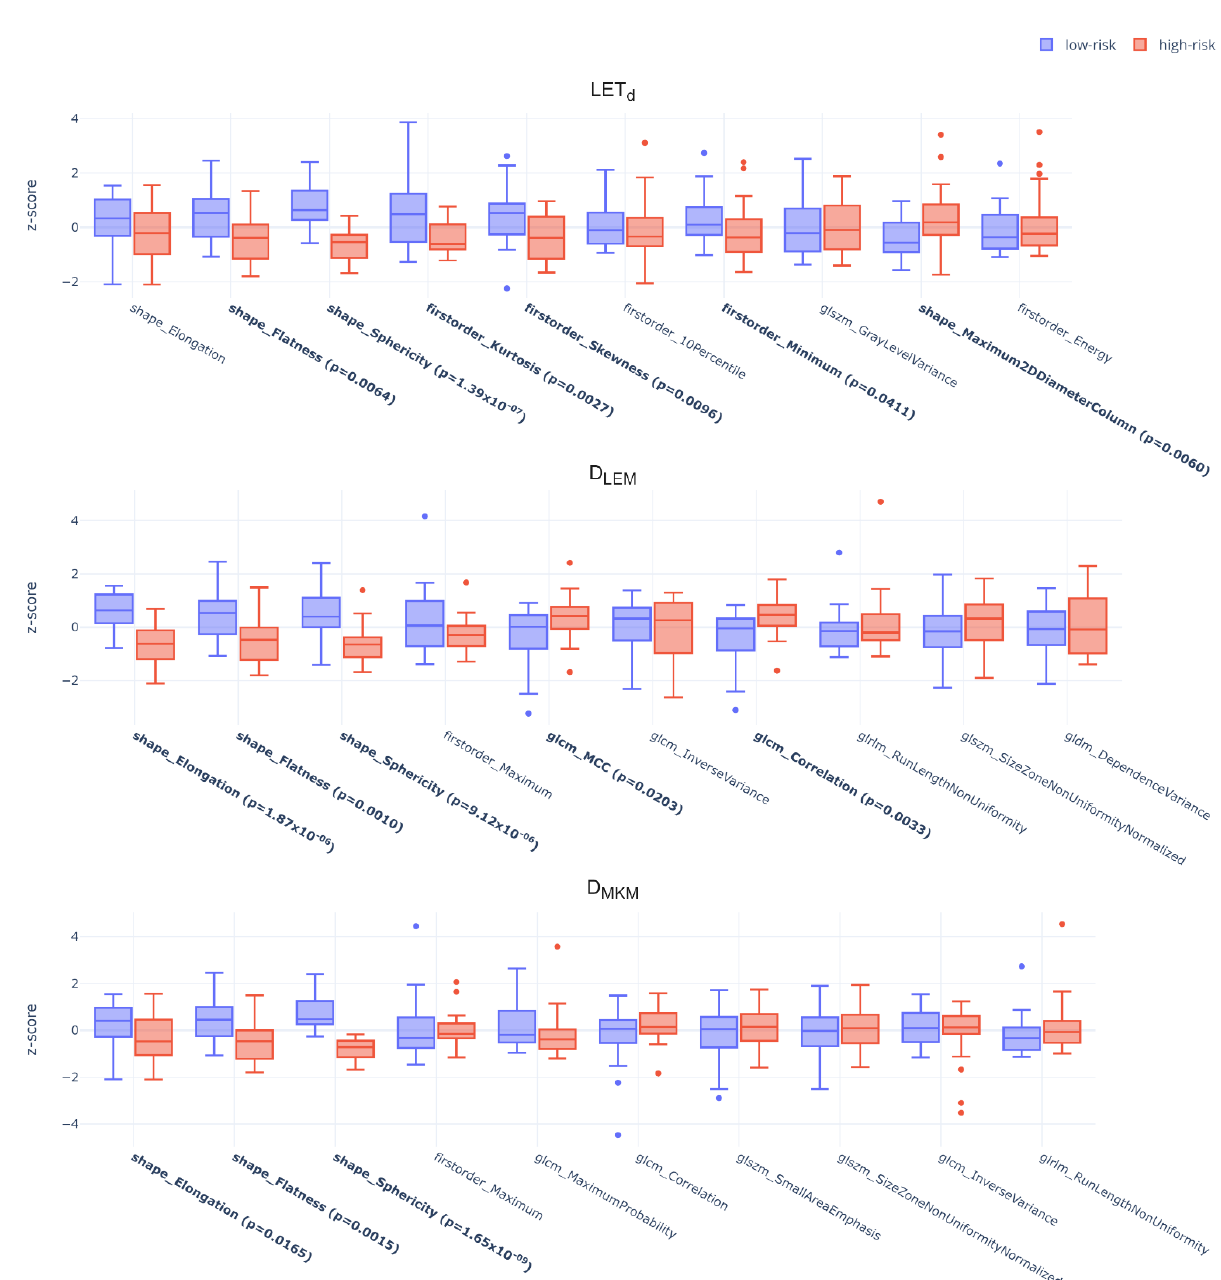
Figure 2. Standardized dosiomics features (LASSO-routine, LET d , D LEM , D MKM from top to bottom) as stratified by r-Cox according to the risk (low-risk in blue, high-risk in red) of LR. Features high- lighted in bold showed statistically significant differences between the two classes (Mann–Whitney U test ( α = 0.05)) and the obtained p -values are reported in brackets. Each label in the boxplot is structured as feature type (i.e., ‘shape’ for shape features, ‘firstorder’ for first order features and matrix name (e.g., ‘glcm’) for texture features) followed by the specific feature name according to PyRadiomics convention. Refer to supplementary materials Section S2 for more details.